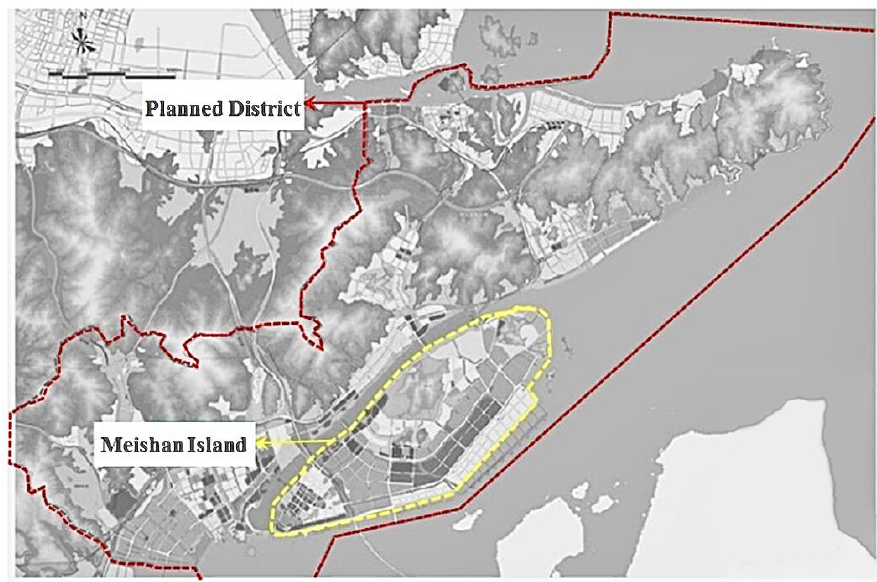
Figure 3. The MINCEDD planning area.